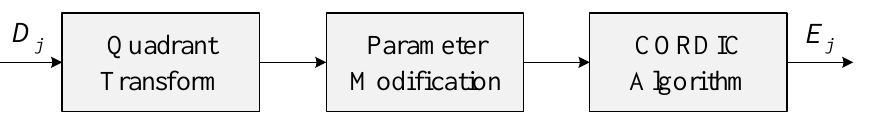
Figure 6. The block diagram of the improved CORDIC